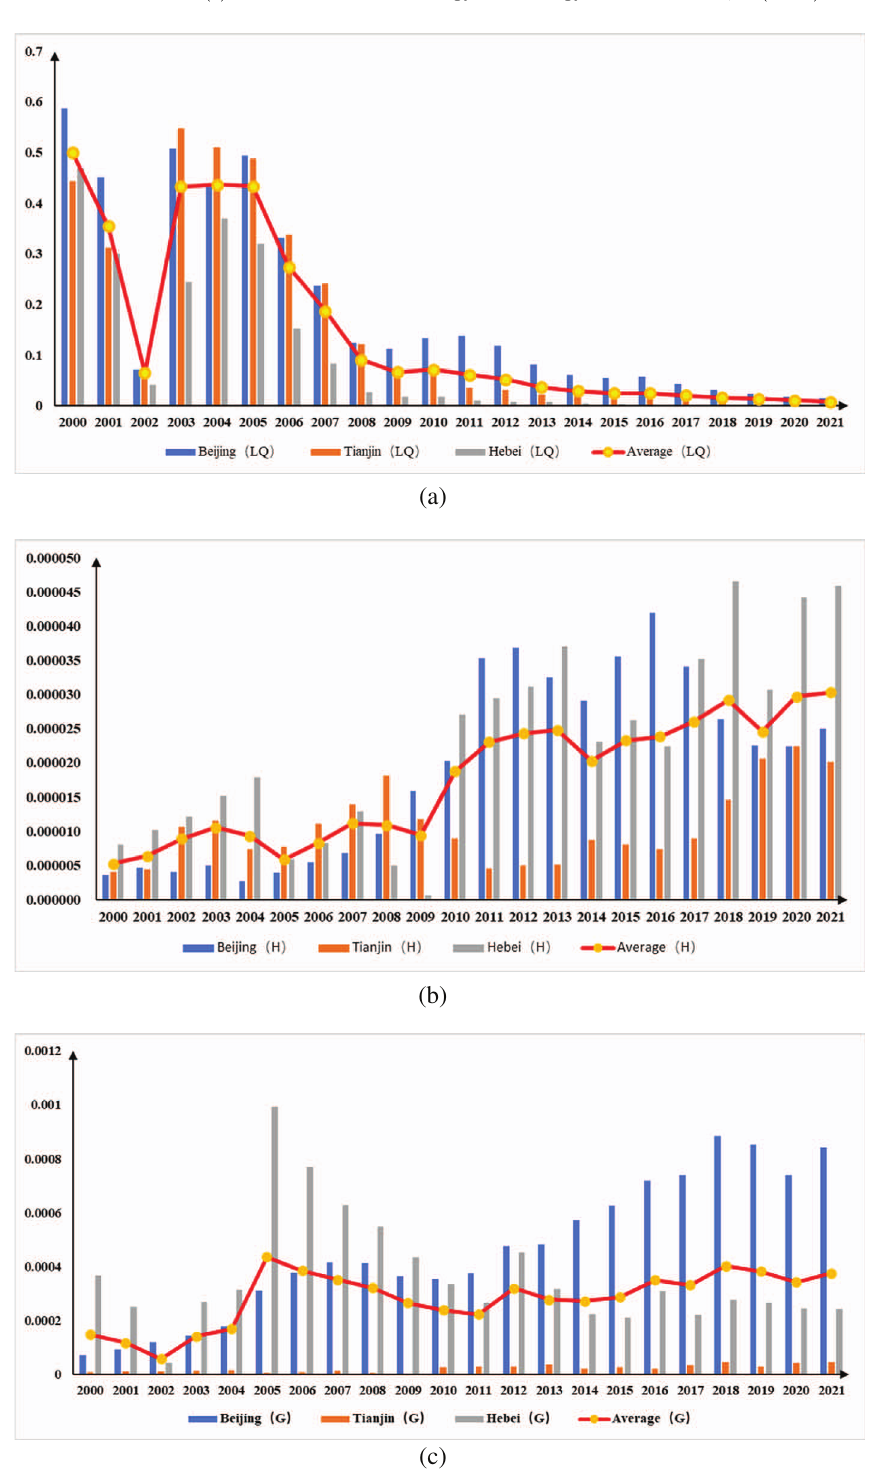
Fig. 3. Agglomeration of renewable energy industry in Beijing – Tianjin – Hebei. (a) Location Quotient (LQ). (b) Her fi ndahl coef fi cient ( H ). (c) Spatial Gini coef fi cient ( G